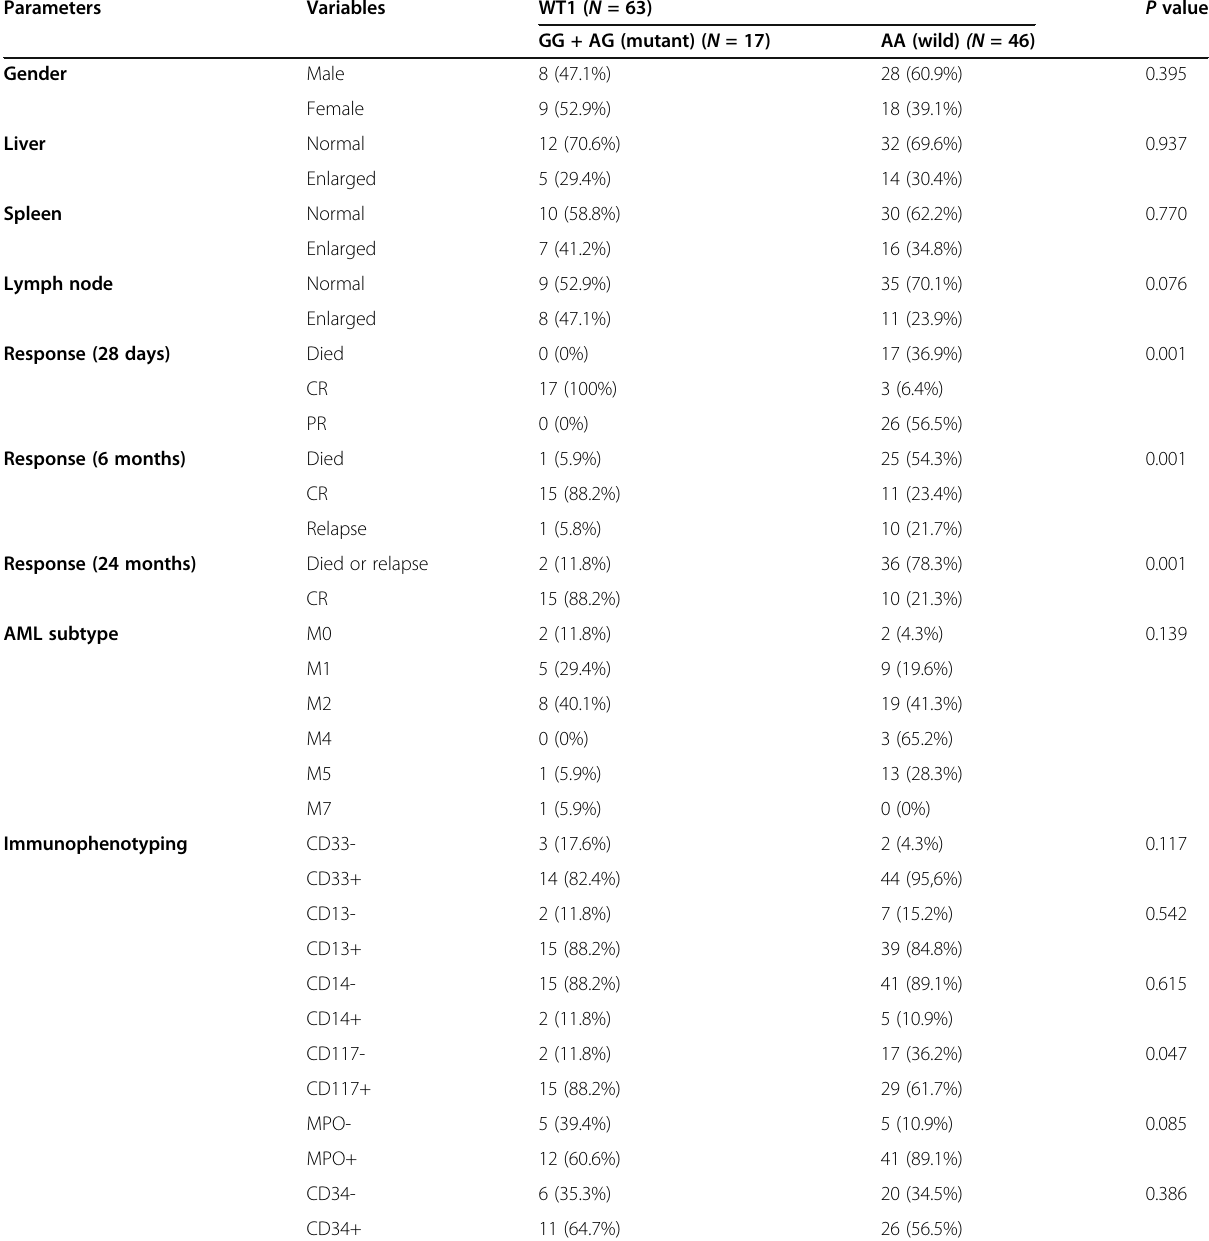
Table 4 Comparison between WT1 genotyping and AML patients ’ data Parameters